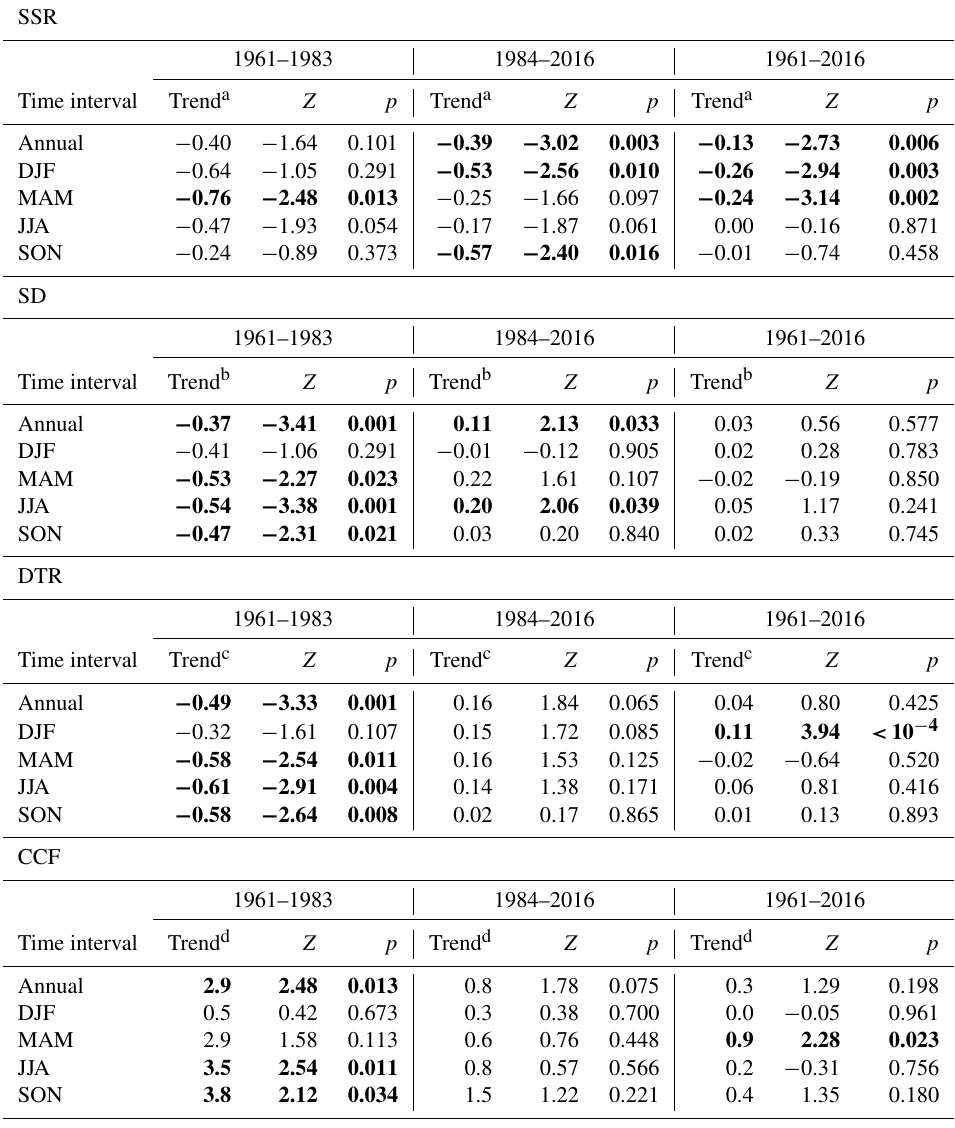
Table 1. Modified Mann–Kendall trend test results for period 1, from 1961 to 1983; period 2, from 1984 to 2016; and for all the analysed years, from 1961 to 2016, considering each season and on an annual basis for the surface solar radiation (SSR), sunshine duration (SD), diurnal temperature range (DTR) and sky cover fraction (CCF). The trend was estimated as the slope of the linear fit between the variable of interest and year. Bold numbers refer to statistically significant trend values at the 95% confidence